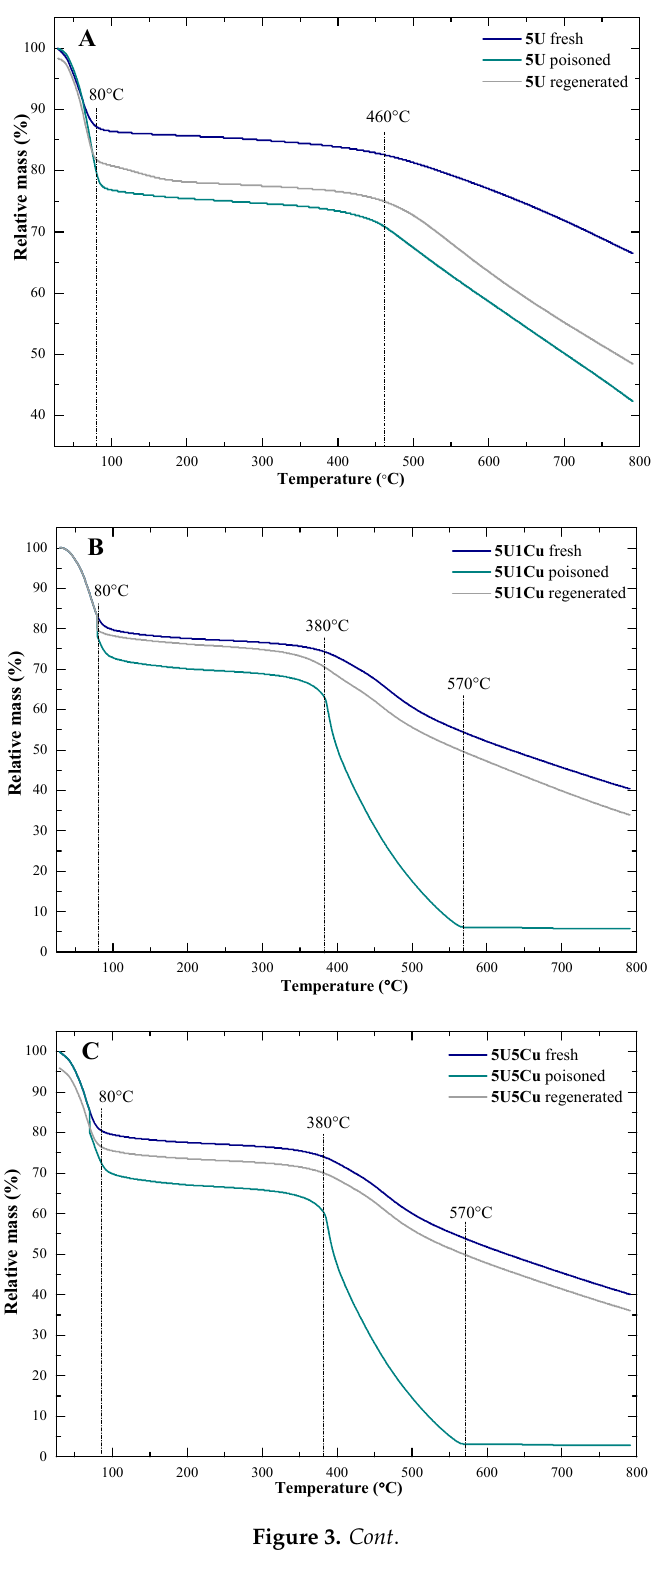
Figure 3. Cont Figure 3. Results of thermogravimetric analysis obtained for fresh, poisoned, and regenerated: ( A ) 5U; ( B ) 5U1Cu; ( C ) 5U5Cu; ( D ) 5U10Cu.